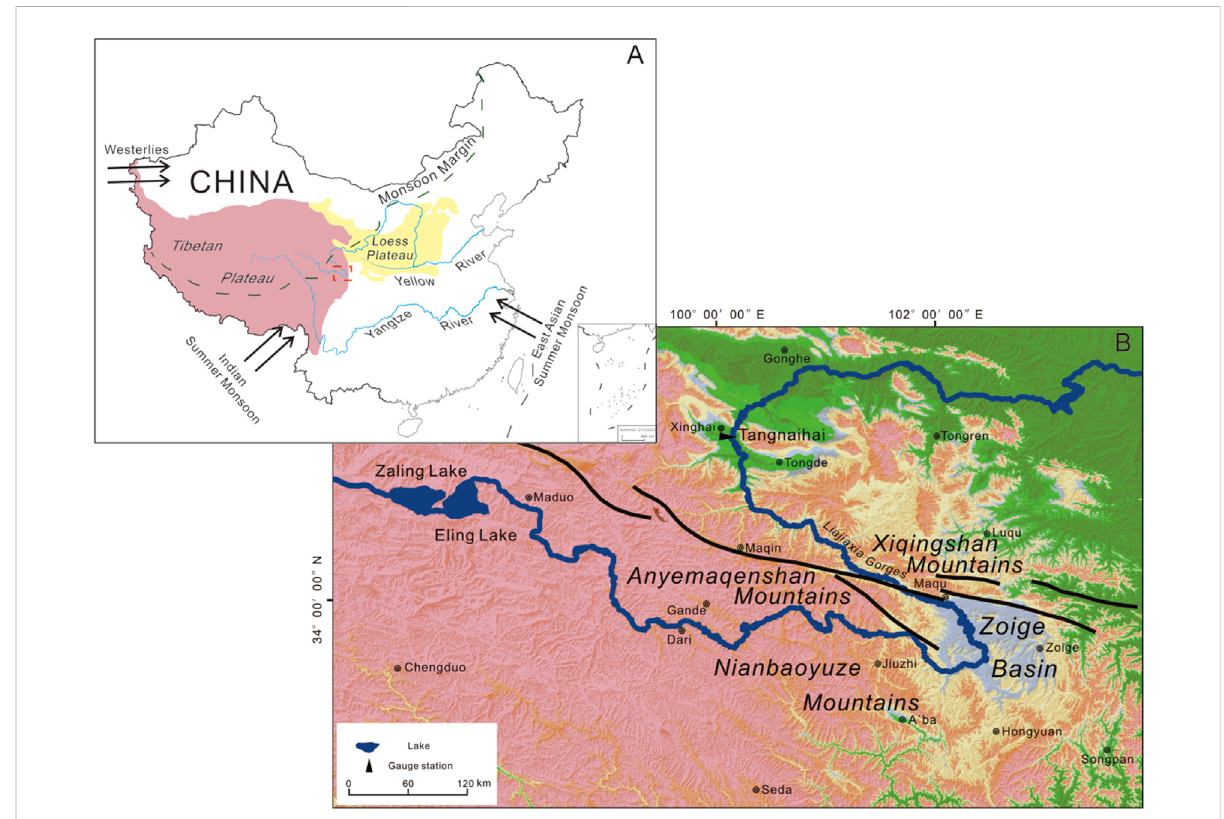
FIGURE 1 (A) Map showing the Maqu-Kesheng reach downstream of the Zoige Basin (red square) in the Yellow River source area on the NE Tibetan Plateau. (B) Map showingdrainage basin, major fault zones (markedwith ‘‘ ’’ )(He et al.,2006)and topographical features of theYellow River source area on the NE Tibetan